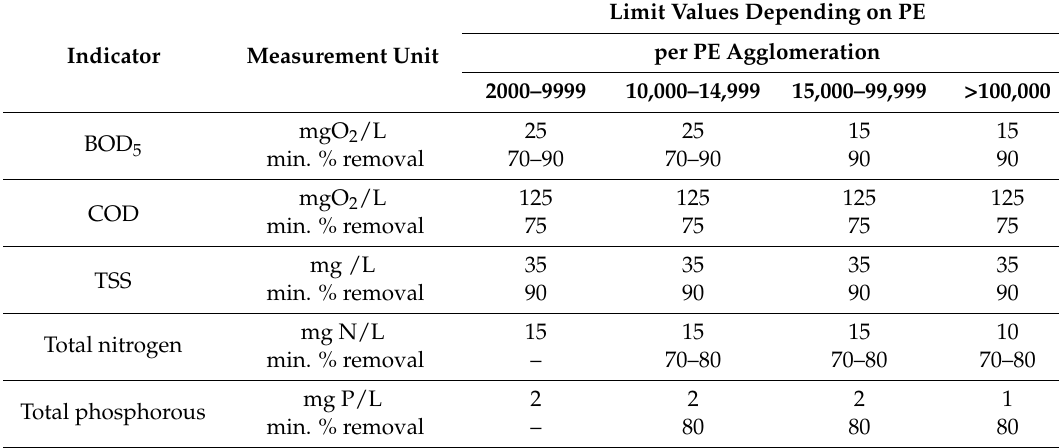
Table 10. The highest permissible values of pollution indicators or minimum percentage of removal of pollutants for wastewater introduced to water bodies or to soil, according to Polish law [44].